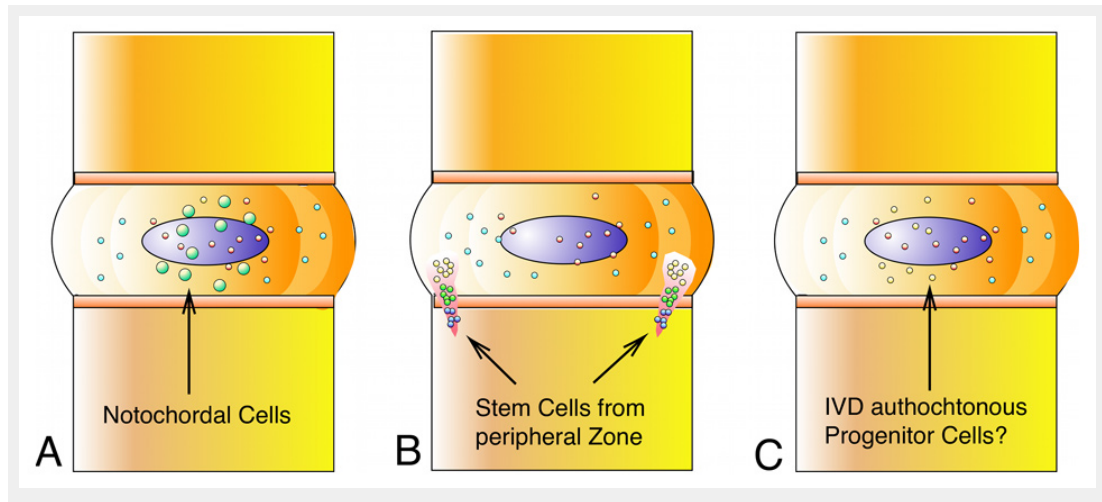
A. Three niches for stem cell-like progenitor cells (SCLC) in the intervertebral disc (IVD): A. Notochordal cells with regenerative capacity remain persistent in the IVD at different ratios and at different stages in the lifetime (according to [47, 50, 51]) B. The perichondrium region (PR) close to the outer annulus fibrosus acts as a densely packed center where cells migrate out of the PR with 2 zones of interest: perichondrium region of interest 1 (P roi 1) with densely packed cells (red) and perichondrium region of interest 2 (P roi 2) with cells (yellow) that are more dispersed and morphologically mature [41]. C. Intervertebral-disc like progenitor cells could be present in the intervertebral disc itself [38, 39].